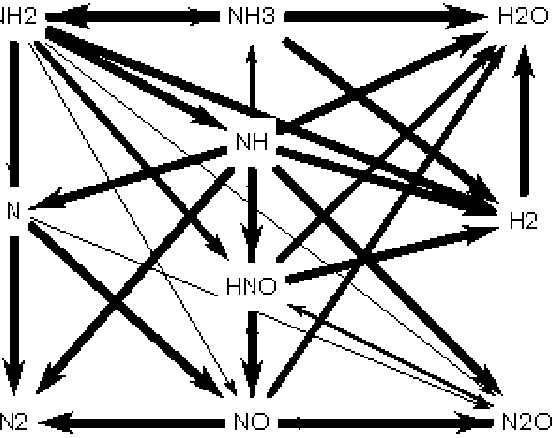
Figure 4. Path of NO formation in the primary combustion zone. Reprinted with permission, Elsevier, 2020 [5].